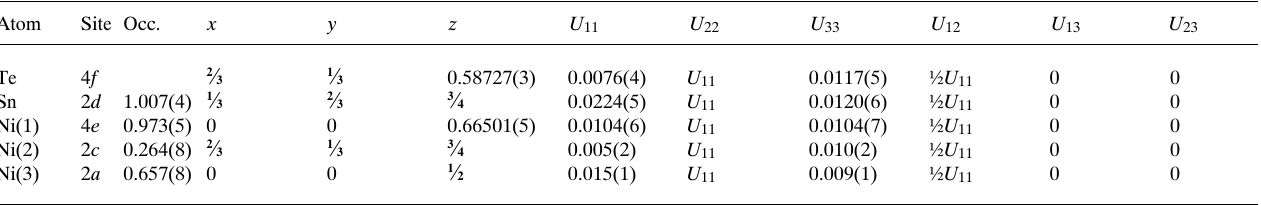
Table 2. Atomic coordinates and displacement parameters (in Å 2 ) . Atom Site Occ.